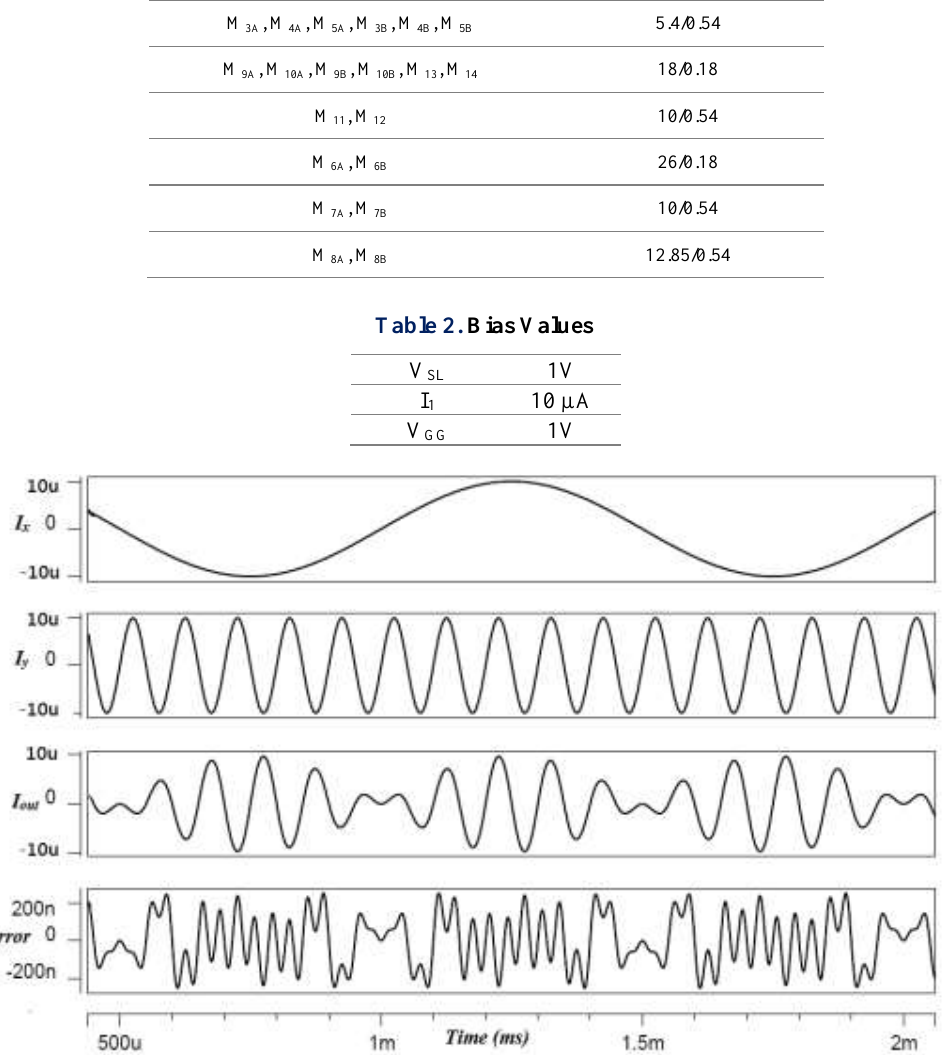
Figure 4. Simulation result of proposed current multiplier circuit and error measurement The input signals are the sine function with different frequencies of 1 and 10 𝐾𝐻𝑧 . As can be seen in Figure 4, the maximum error is less than 2.5%. Figure 5. proves that change in VSL causes variation on the output current